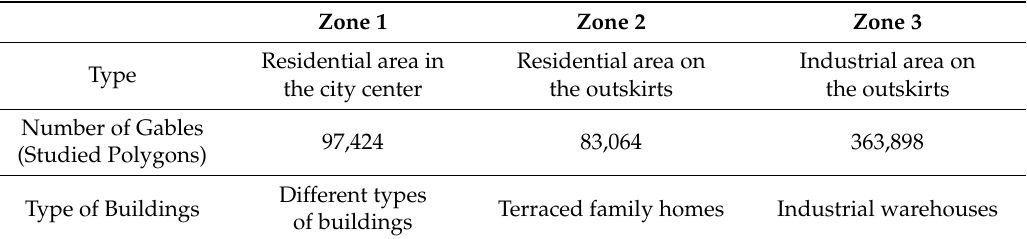
Table 1. Main characteristics of the three study areas.